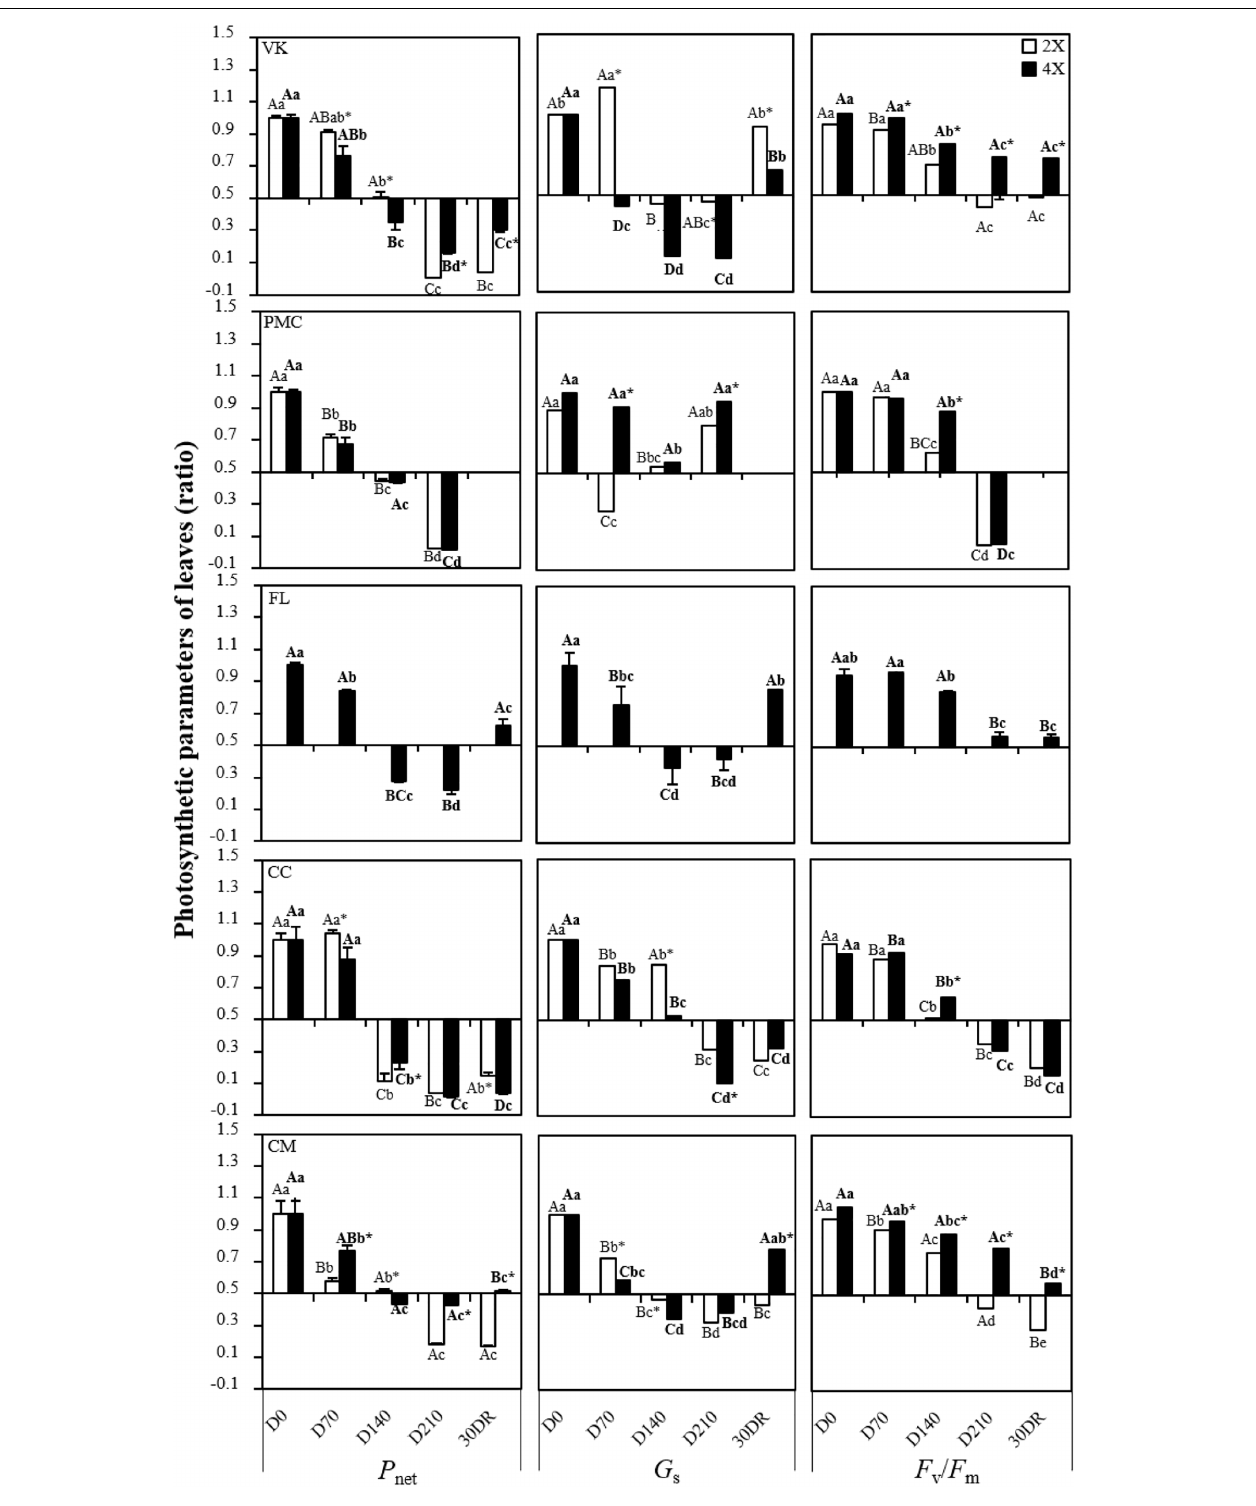
FIGURE 2 | Evolution of net photosynthesis rate ( P net ), stomatal conductance ( G s ) and chlrorophyll fluorescence ratio ( F v / F m ), throughout the nutrient deficiency in leaves of 2x and 4x seedlings. The white and black bars correspond to the values obtained from 2x and 4x seedlings, respectively.